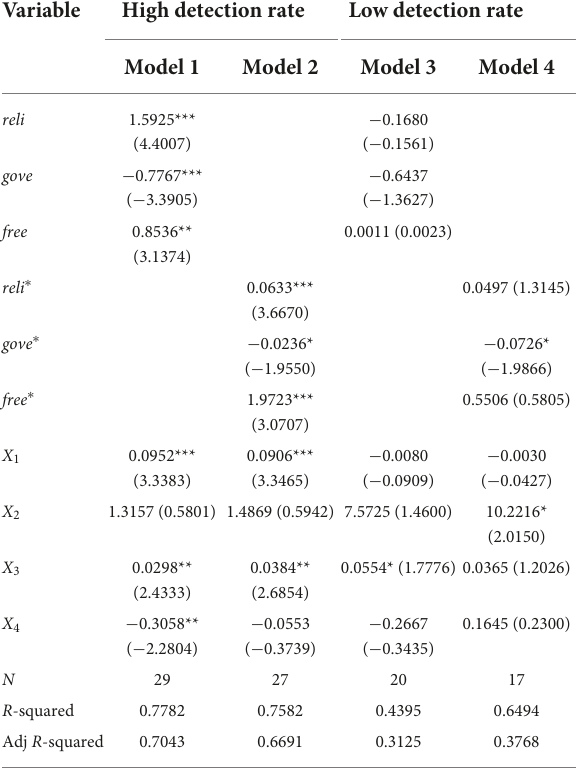
TABLE 7 Regression results for changing study time points. TABLE 8 Regression results for grouping of COVID-19